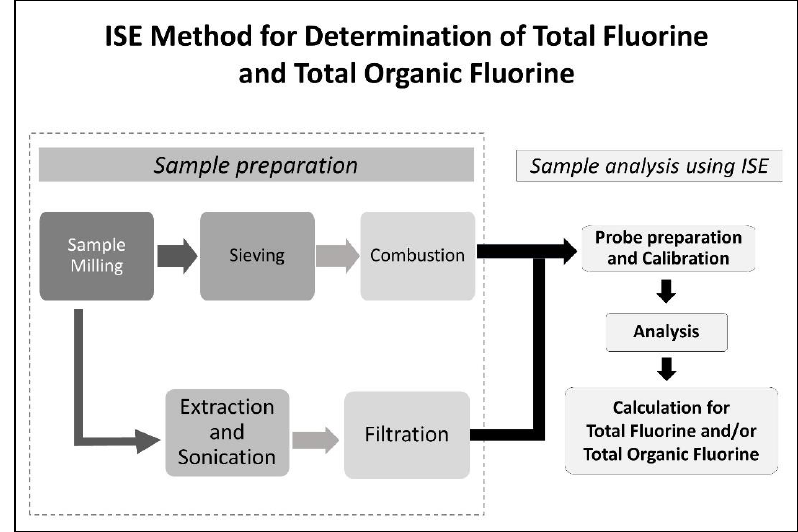
Figure 1. ISE total fluorine and total organic fluorine measurement process chart.